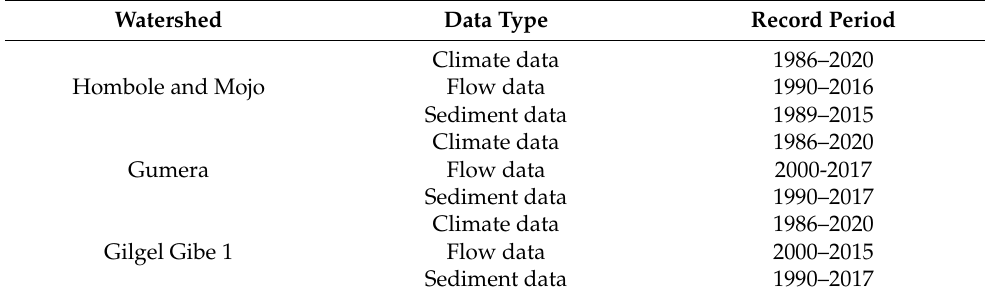
Table A1. Data types and record